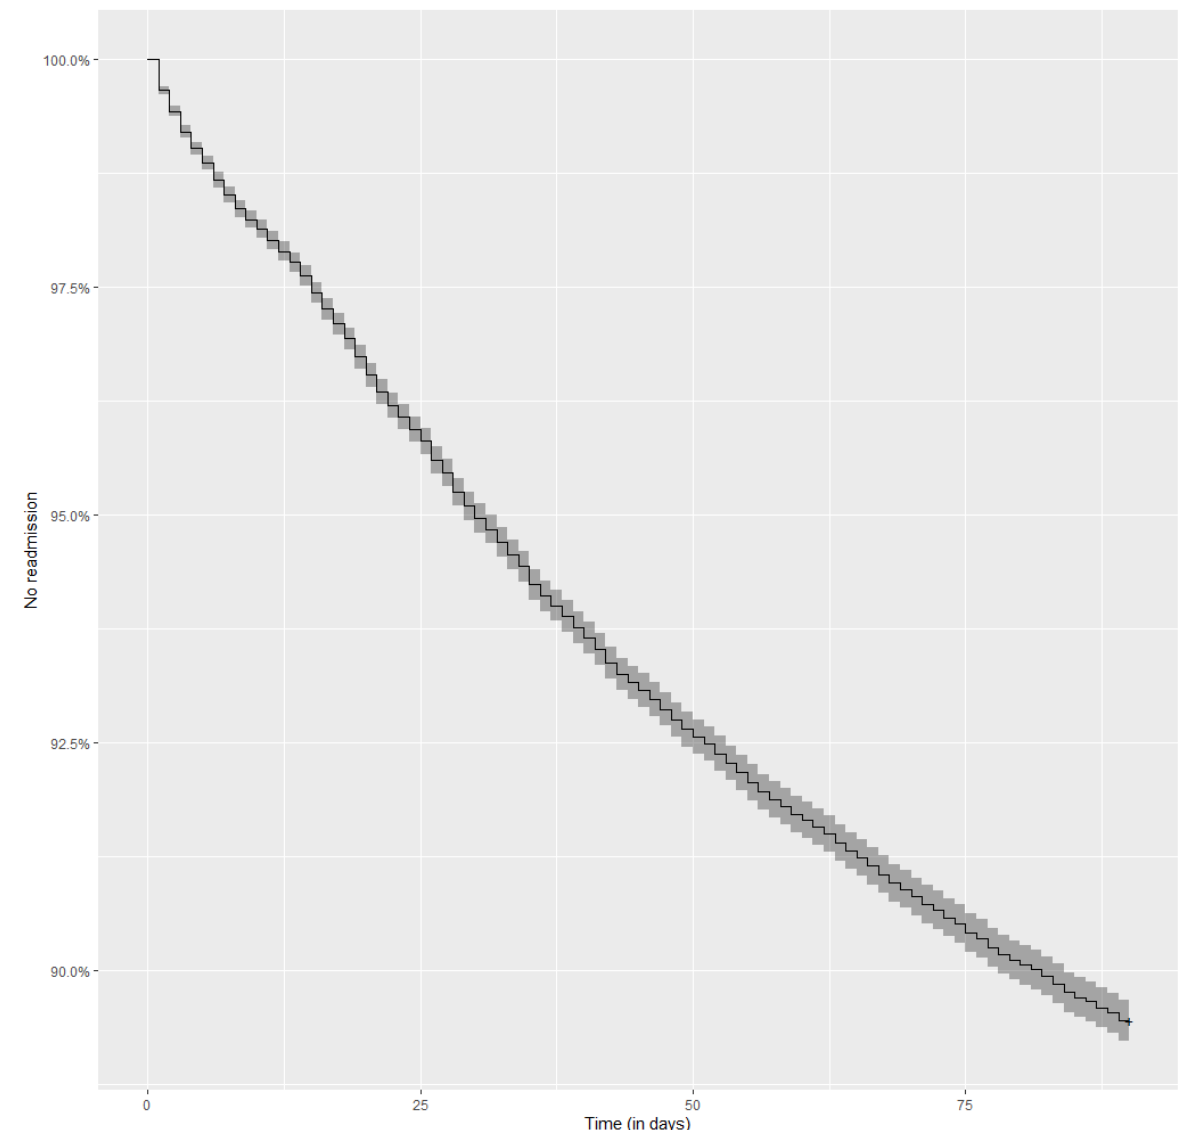
Figure 1. Kaplan–Meier curve representing the risk of readmission over a period of 90 days after a discharge from a diabetes-related index hospitalization. No readmission—% of patient who were NOT readmitted to the hospital over a period of 90 days after discharge from a diabetes-related index